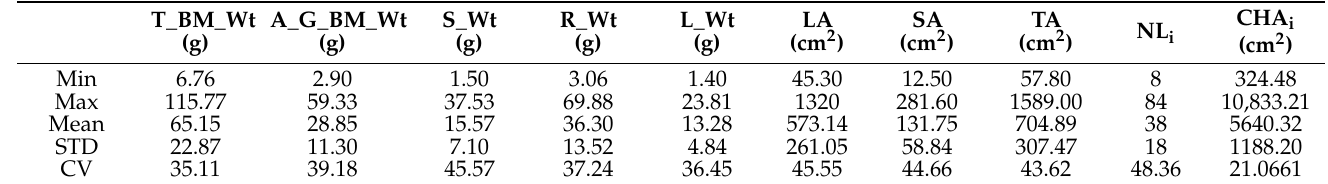
Table 2. Descriptive statistics of the quantitative traits and image traits of different genotypes for